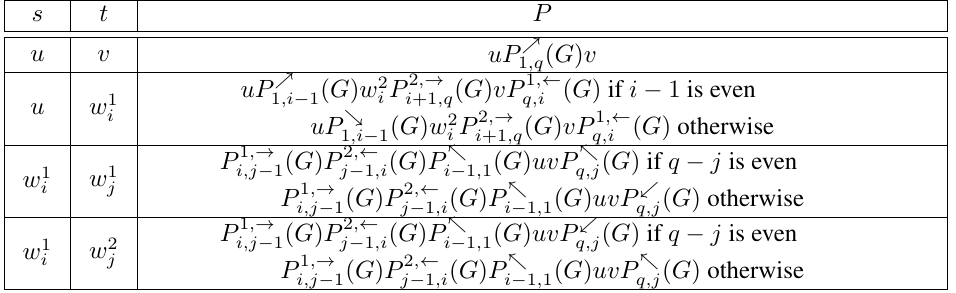
Tab. 1: Proof that Pr n is Hamiltonian-connected for every even n ≥ 4 .